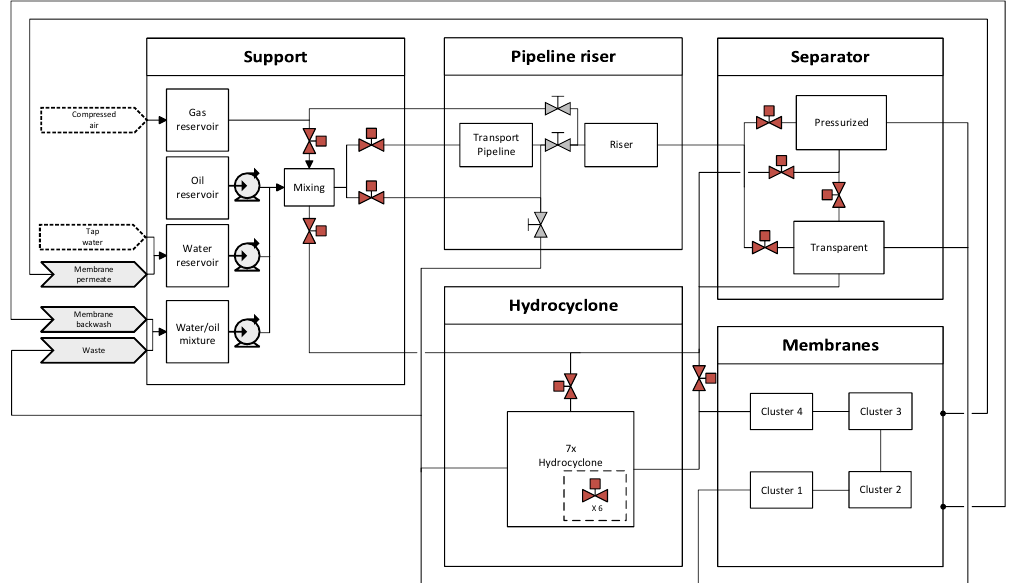
Figure 4. An overview of the bypass structure of the offshore pilot-plant at Aalborg University in Esbjerg.